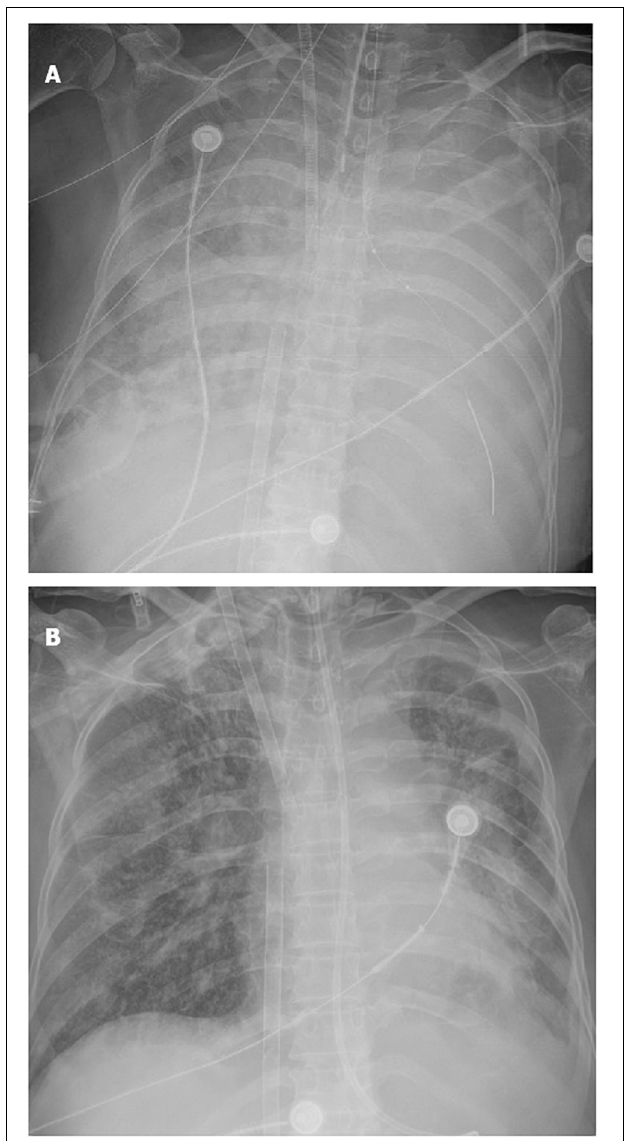
FIGURE 2 | Evolution of the chest X-ray of the patient. (A) Extensive consolidation of both lungs; (B) consolidation of both lungs decreased significantly.